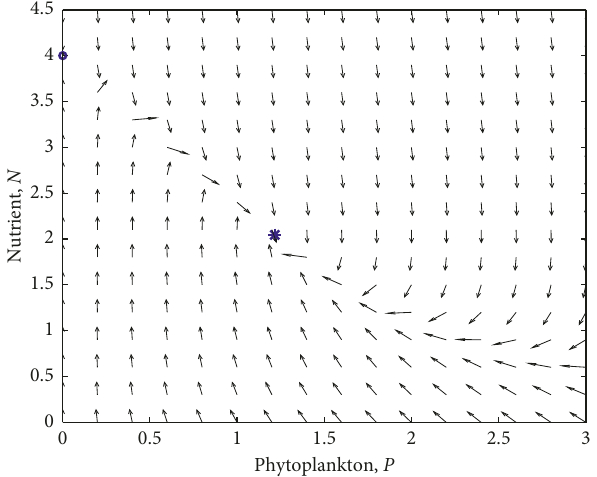
Figure 1: Fixed points of (8). Parameter values: I � 1 . 6, a � 0 . 5, b � 0 . 8, α � 0 . 7, m � 0 . 45, q � 0 . 01, ε � 0 . 001, and τ � 0. ∗ Asymptotically stable fixed point E ∗ ; “ ○ ” represents the boundary fixed point E 0